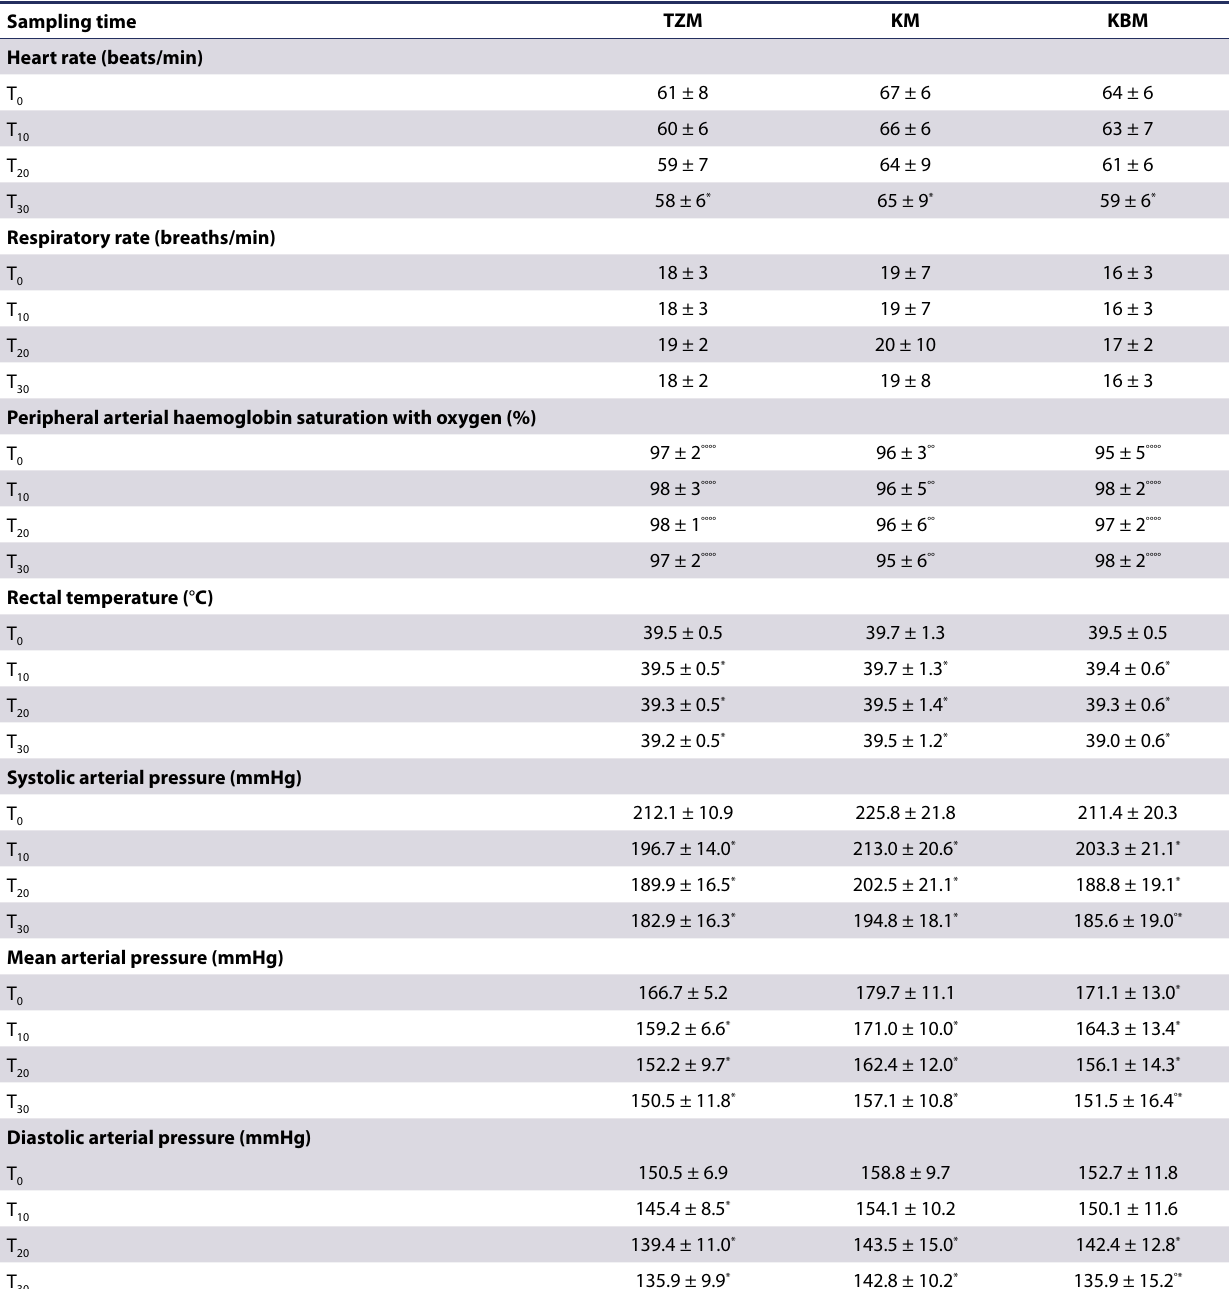
Supplementary Table II: Physiological variables in free-ranging African lion ( Panthera leo ) immobilised with tiletamine-zolazepam-medetomidine (TZM), ketamine-medetomidine (KM) or ketamine-butorphanol-medetomidine (KBM), recorded at 0, 10, 20, and 30 minutes after lateral recumbency. Data are presented as mean ± SD, ( n = 12 per drug